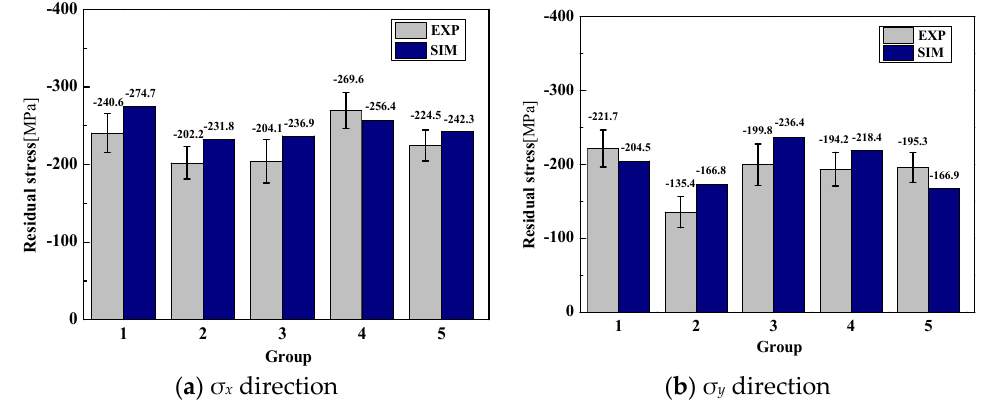
Figure 6. Experimental and simulated chip morphology: ( a ) θ = 35°, V c = 20 m/min, f z = 0.07 mm/rev; ( b ) θ = 55°, V c = 20m/min, f z = 0.03 mm/rev. Table 4. Experimental and simulated surface residual stress.